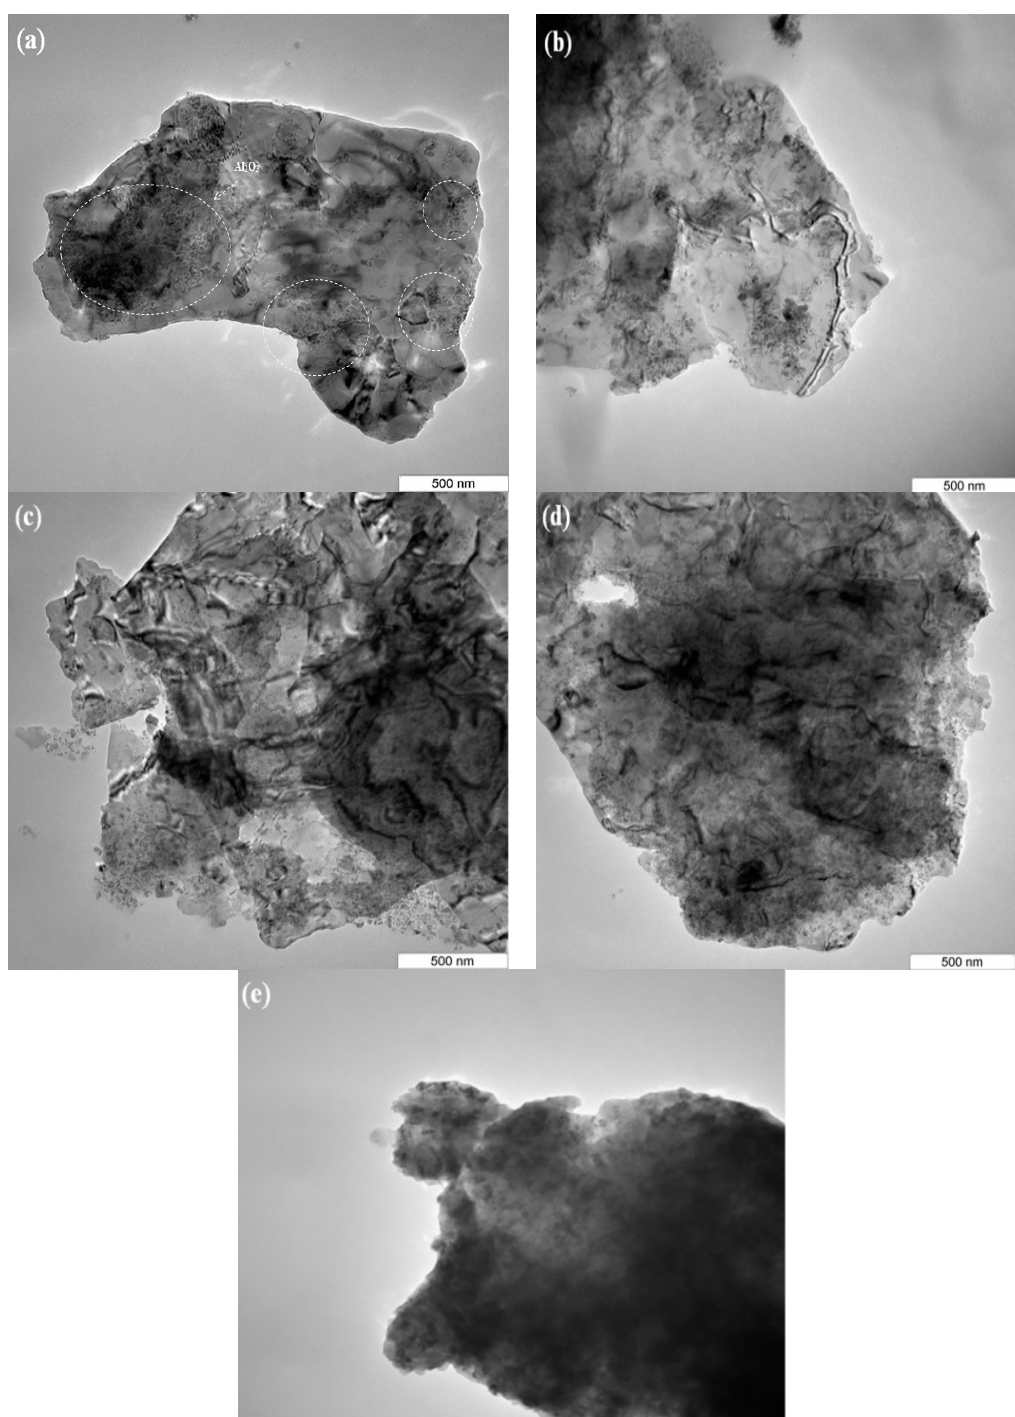
Figure 2. TEM micrograph of Al-5 wt % Al 2 O 3 powder mixture milled for different times ( a ) 0.5 h; ( b ) 2 h; ( c ) 5 h; ( d ) 8 h; and ( e ) 12 h. ( b ) 2 h; ( c ) 5 h; ( d ) 8 h; and ( e ) 12